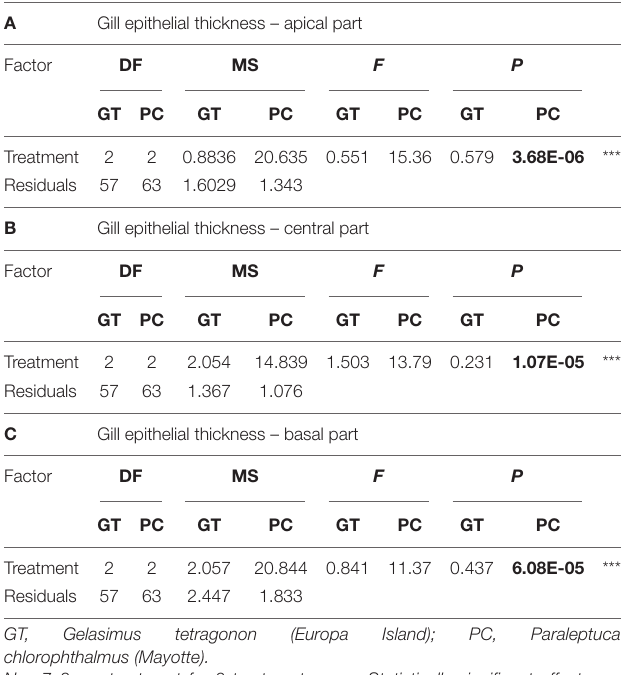
TABLE 2 | Results of analysis of variance for gill epithelial thickness measured on different parts of the longitudinal axis of the gill one-way